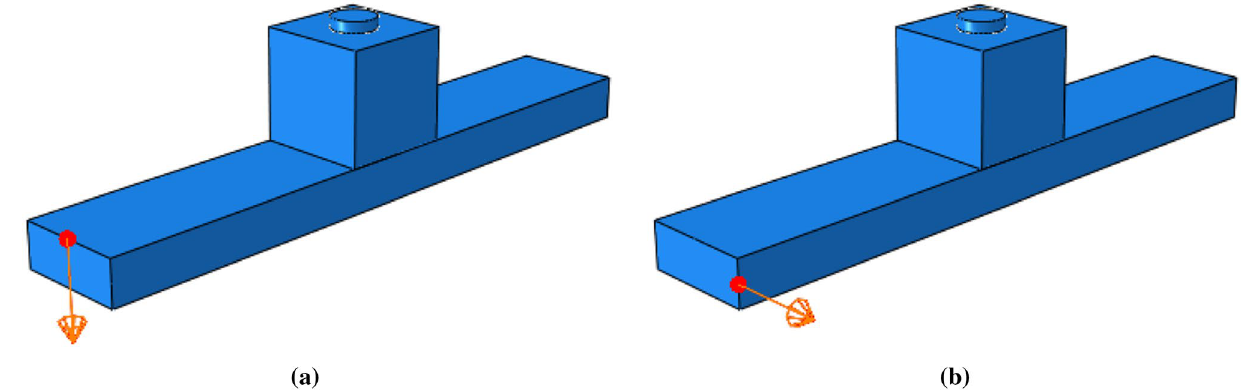
Fig. 4 Location and direction of excitation force for the a first and b second mode of